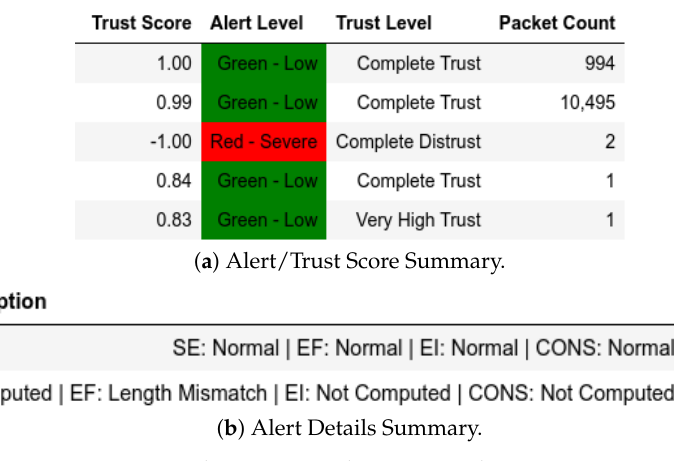
Figure 25. Server: ATENA H2020 dataset external test- H M in clean capture.